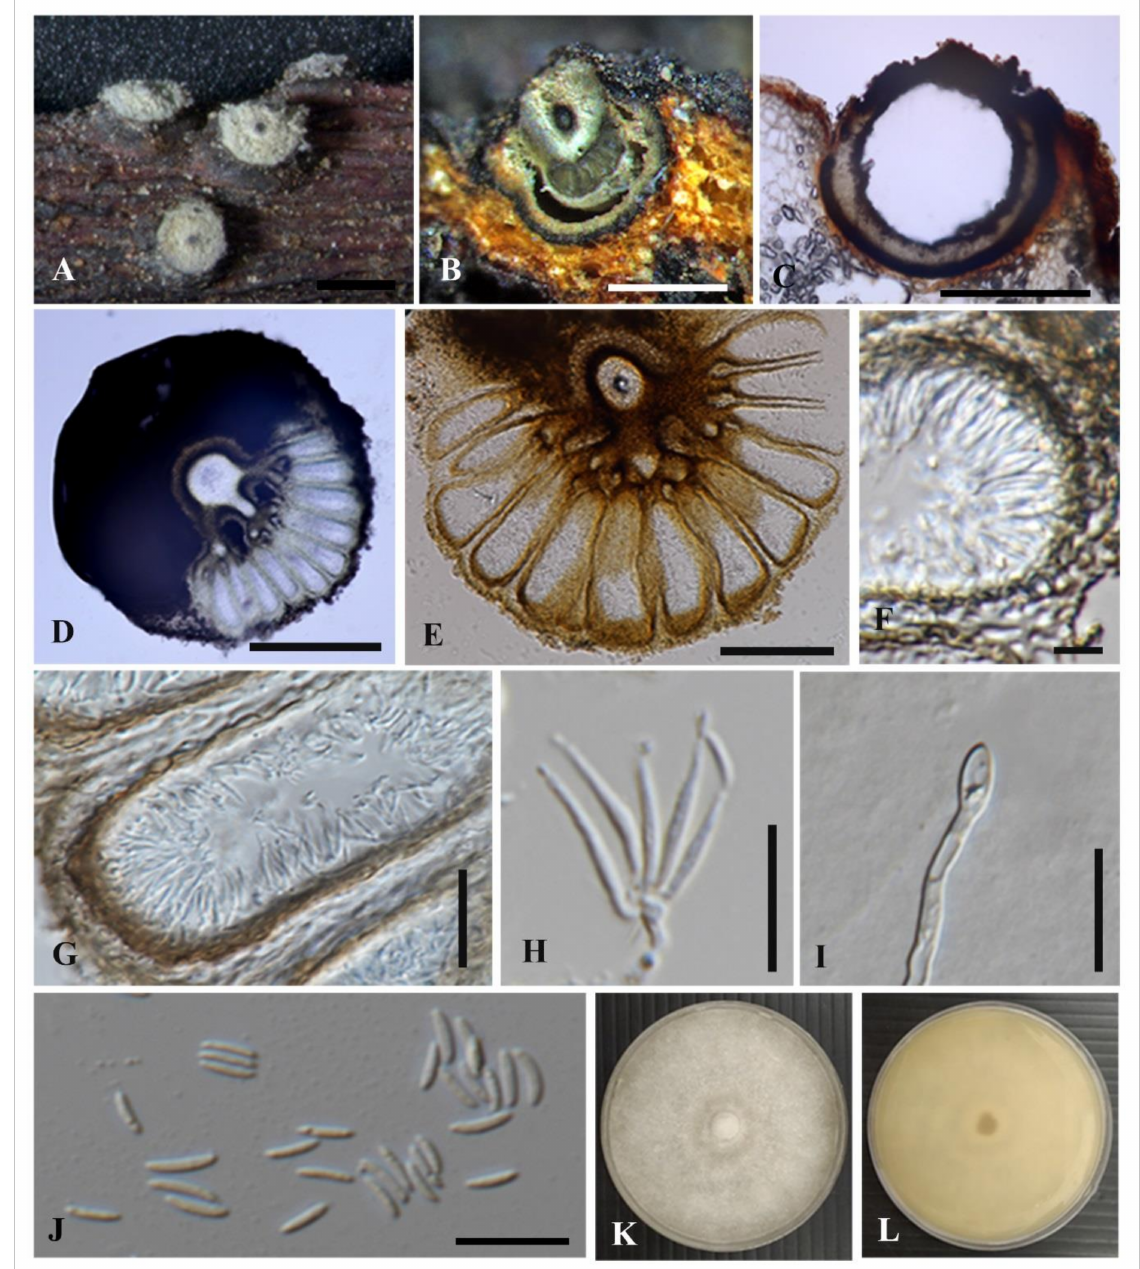
Figure 4. Cytospora chiangmaiensis (MFLU 21-0048, holotype). ( A ) Conidiomata on host substrate. ( B – D ) Longitudinal sections through conidioma. ( E ) Conidiomata with ostiole and the arrangement of locules. ( F , G ) Peridium. ( H ) Conidiophore and conidiogenous cells with attached conidia. ( I ) Germinating conidia. ( J ) Conidia. ( K , L ) Colony on PDA plate (9 cm diam.) (( K ) from above, ( L ) from reverse). Scale bars: ( A – C ) = 500 µ m, ( D , E ) = 100 µ m, ( G ) = 50 µ m, ( F , H – J ) = 10 µ